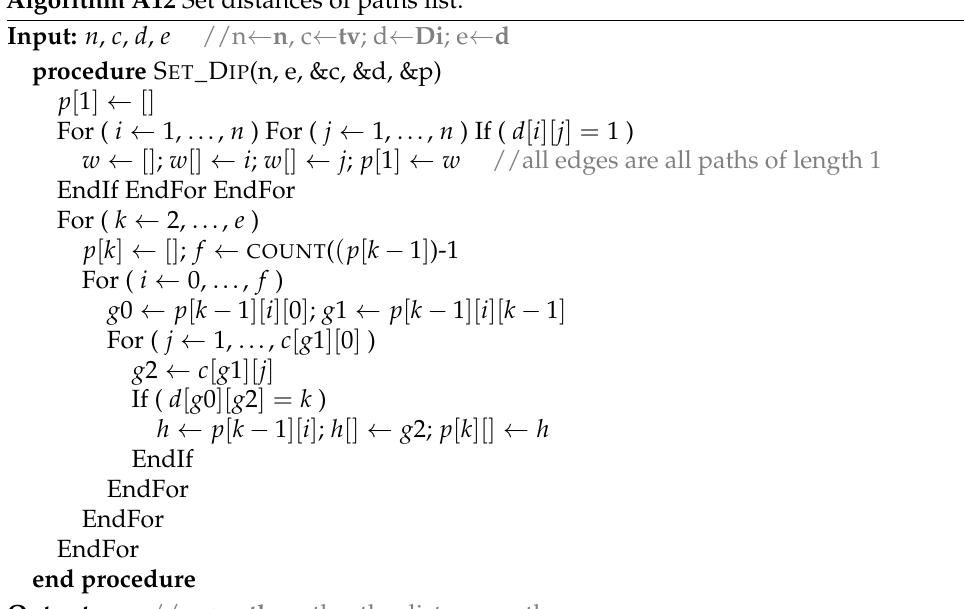
Algorithm A12 Set distances of paths